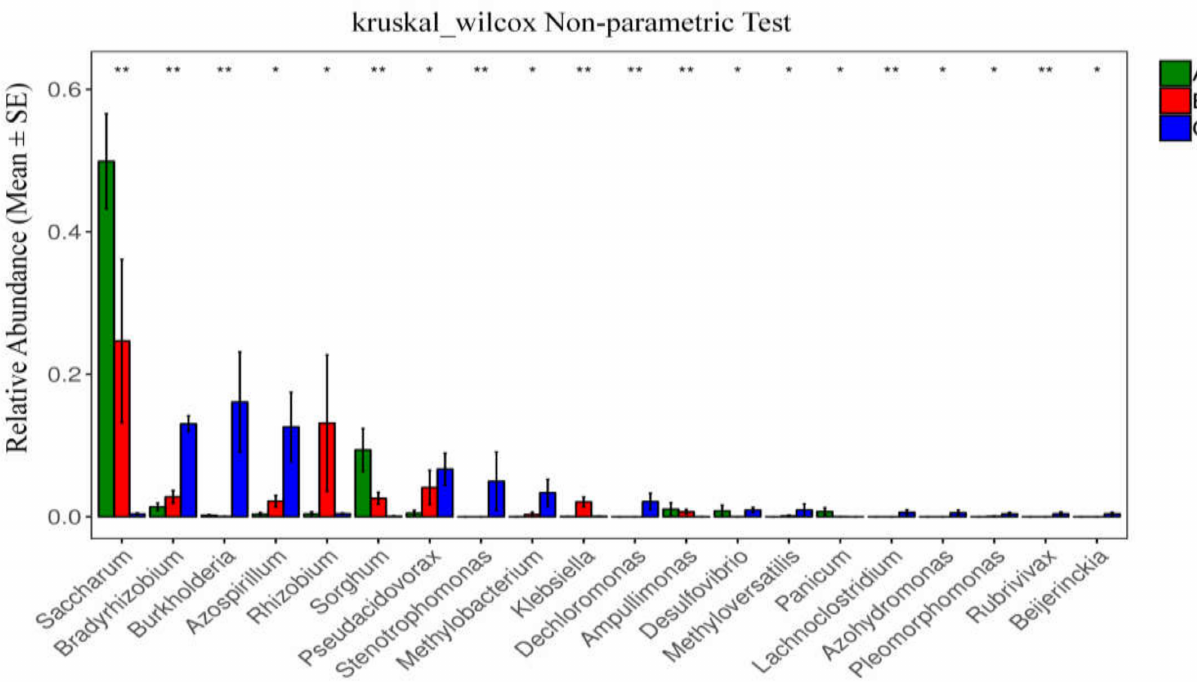
Figure 7. Species difference analysis at each classification level. Each column is the relative abundance of the different species. The error line is standard error, where * represents 0.01 < p < 0.05 and ** represents 0.001 < p <